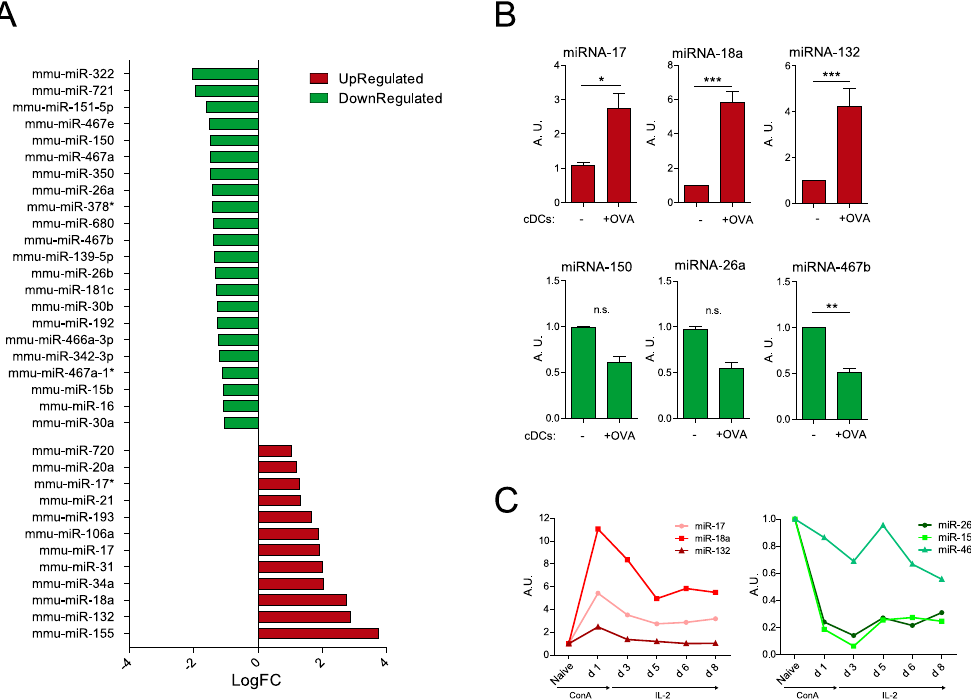
Figure 1. microRNA profile of CD4 T cells activated by cognate interaction with cDCs. CD4 T cells from OT-II mice were cocultured with cDCs in the presence or absence of OVA peptide for 18 h and their miRNA analyzed by miRNA microarray. (A) Comparison of miRNAs expression on T cells after stimulation by cDCs loaded or not with OVA peptide. (B) Selected miR-17-5p, miR-18a-5p, miR-132-3p, miR-26a-5p, miR-150-5p and miR- 467b-5p miRNAs were validated by RT-qPCR. miRNAs that were detected by microarrays to be upregulated or downregulated are depicted in red and green respectively. (n = 8) (C) miRNA levels were assessed by RT-qPCR in freshly isolated mouse naive CD4 T cells in different time points of activation with ConA followed by IL-2. (Plots are representative of two independent experiments). RNU1A1 and RNU5G were used as endogenous controls and data are presented in arbitrary units (A.U.). *** P < 0.001; ** P < 0.05; ns,